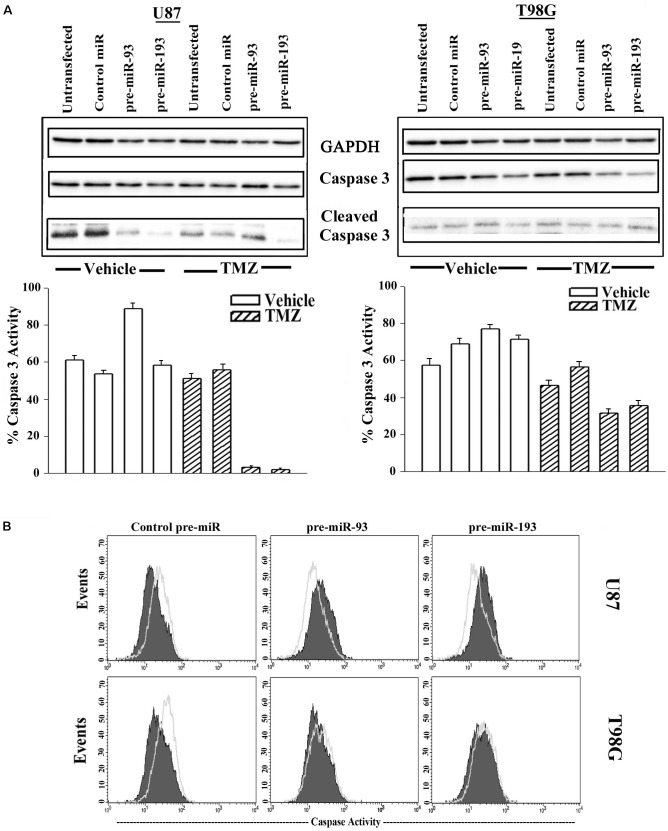
Active caspase 3 in TMZ and pre-miR-93 and -193 transfected GBM cells. (A) U87 and T98G cells were untransfected for transfected with control pre-miR, pre-miR-93 or -193. The cells were treated with vehicle or 200 μM TMZ for 72 h. Whole cell extracts were analyzed in western blots for total caspase 3 and cleaved caspase 3. The normalized band densities were presented as the % caspase activity ((cleaved caspase/total + cleaved caspase) × 100%) (lower graphs). (B) U87 and T98G were transfected with control pre-miR, pre-miR-93 or -193. The cells were treated with vehicle or 200 M TMZ for 72 h. The cells were labeled intracellularly for cleaved caspase 3 (open histogram) and total caspase (solid histogram).